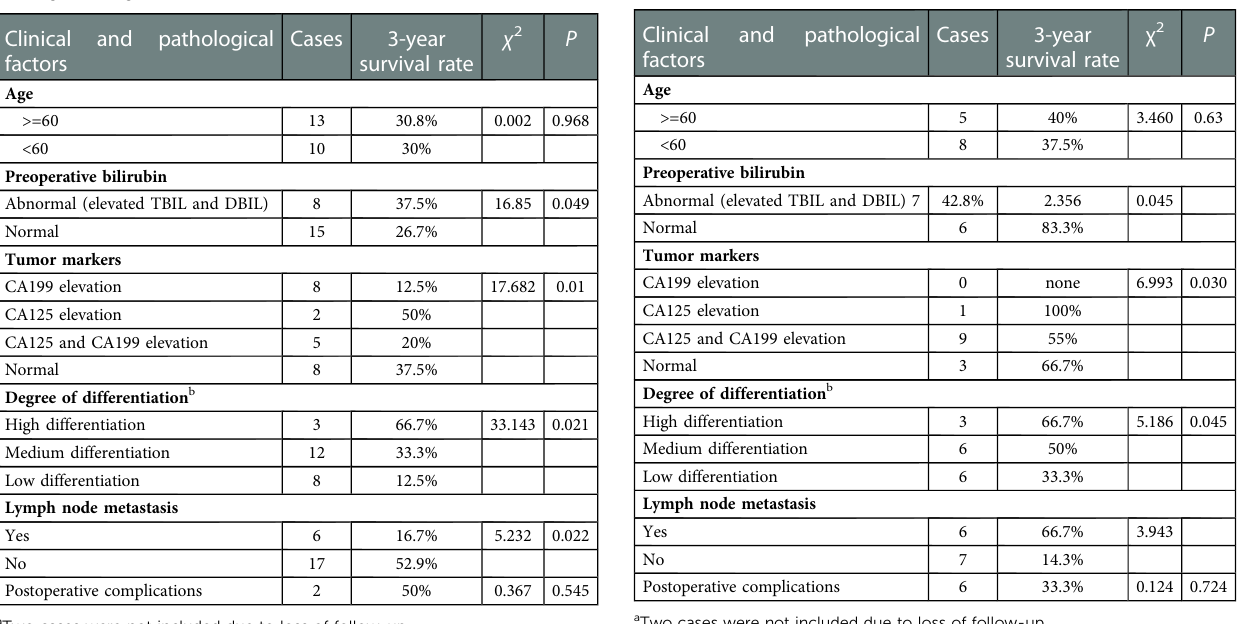
TABLE 1 Univariate analysis of prognostic factors in patients with gallbladder cancer undergoing 2 cm wedge resection of liver and cholecystectomy a .